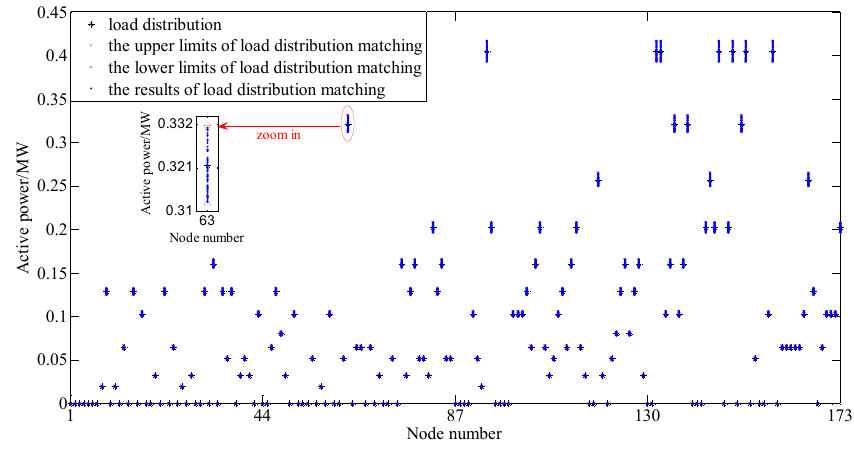
Figure 7. The result of load distribution matching at 17:00.